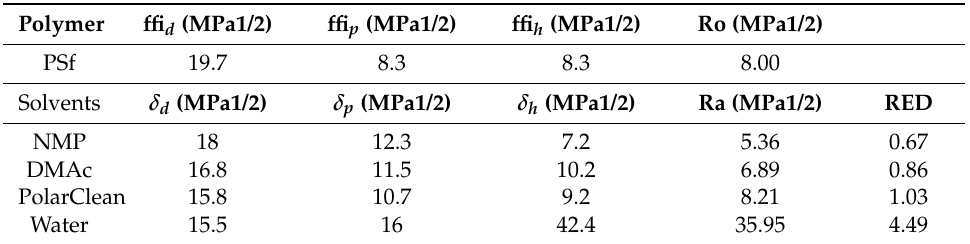
Table 3. Relative energy density calculation for picked solvents and